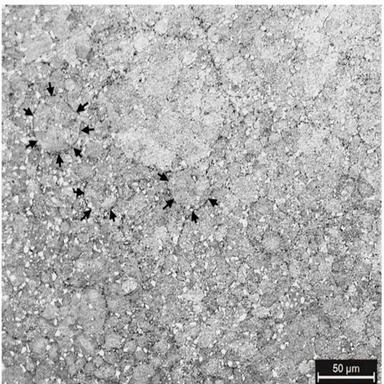
Optical micrograph of superalloy highlighting PPBs (indicated with black arrows).